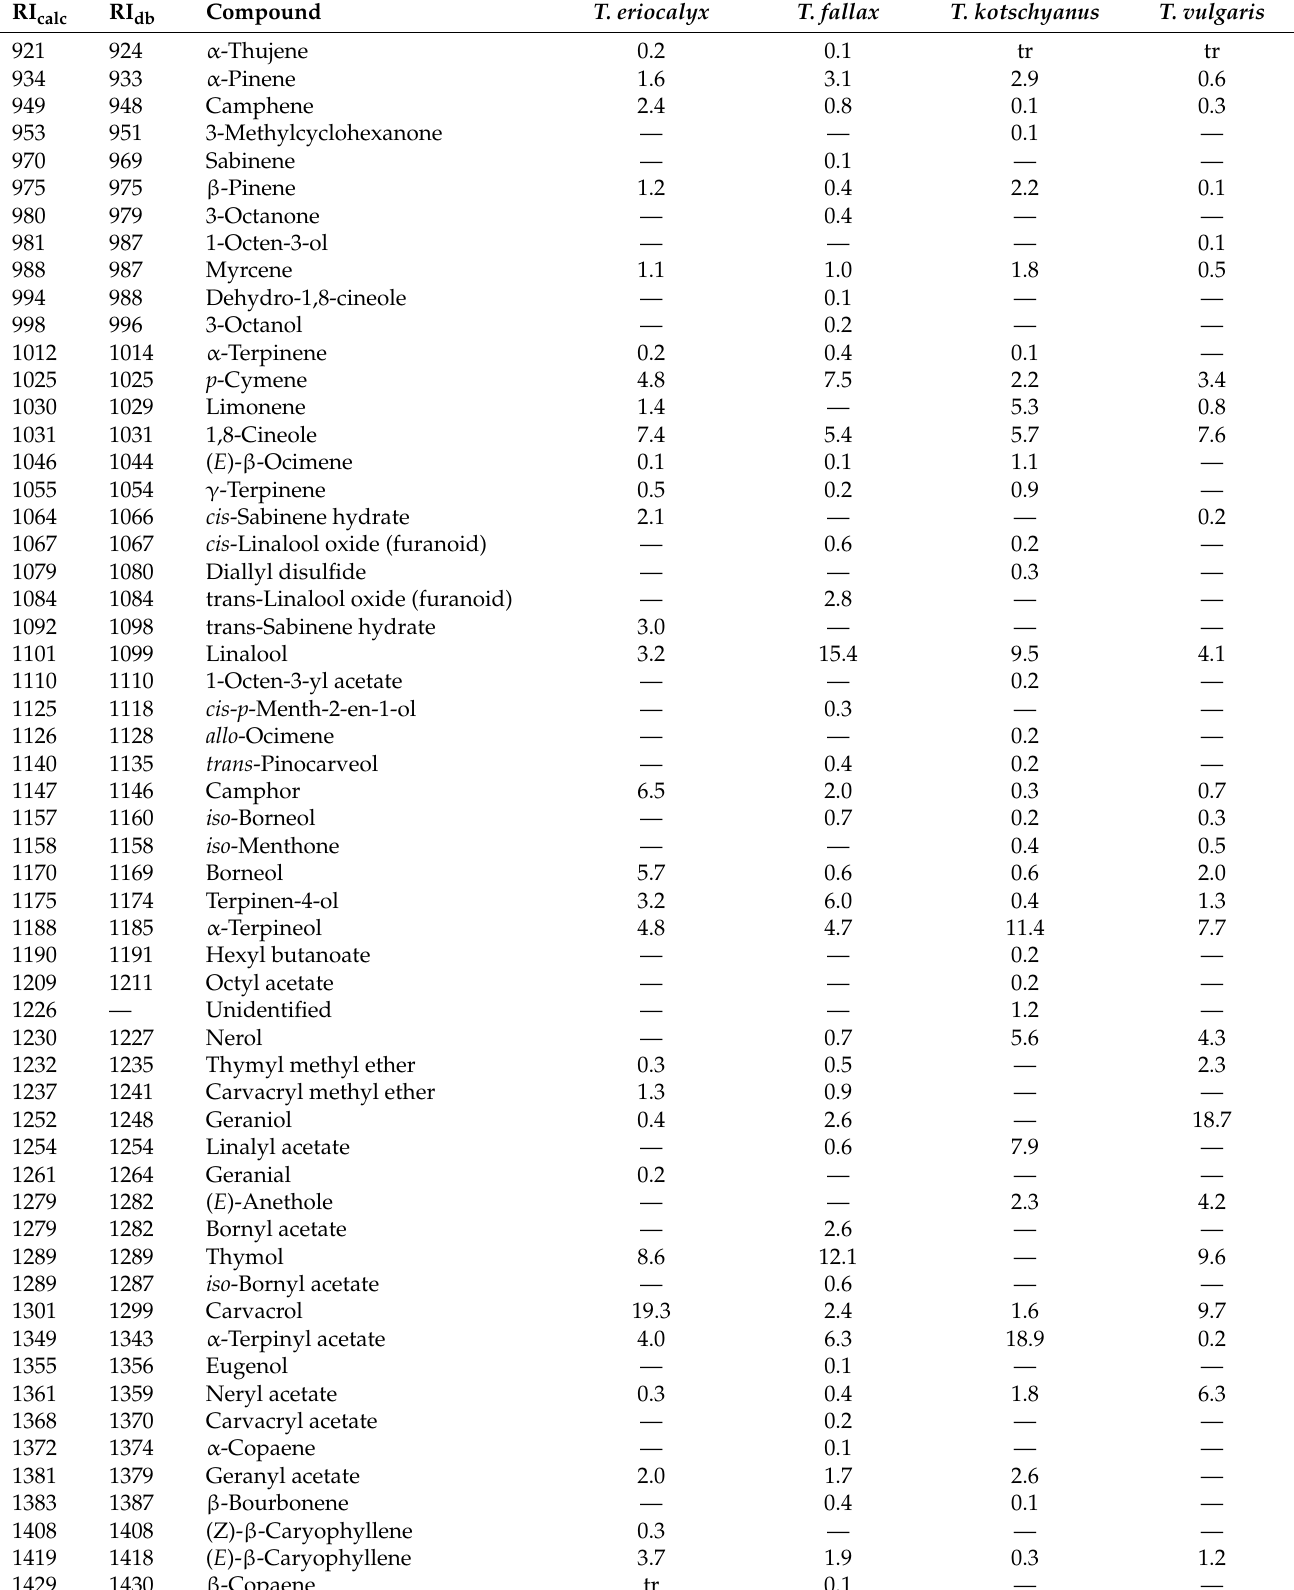
Table 1. Chemical composition (%) of essential oils isolated from aerial parts of Thymus